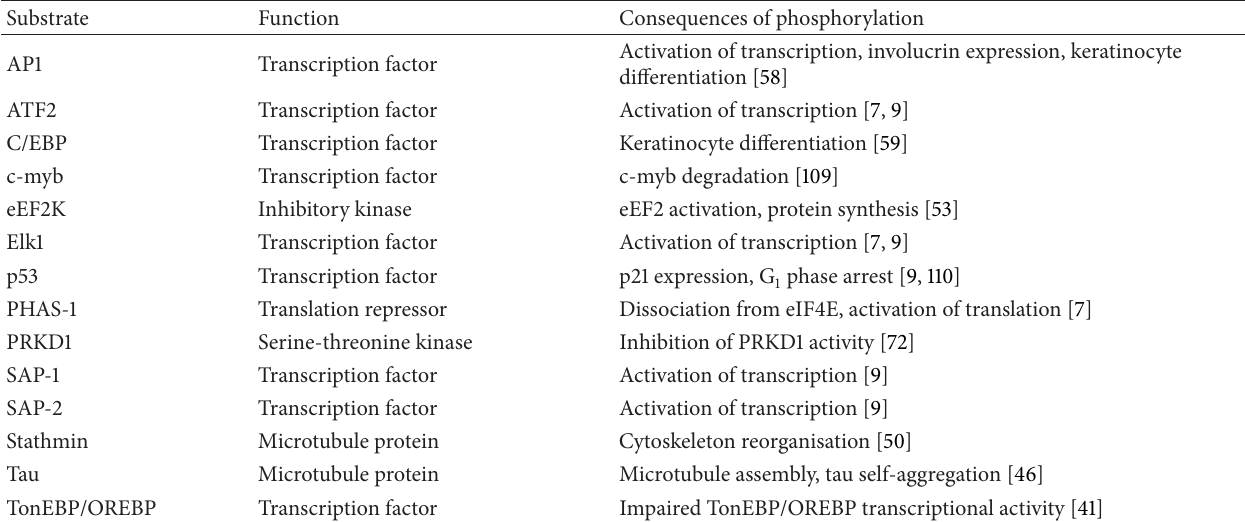
Table 1: Known p38 𝛿 MAPK substrates and their biochemical